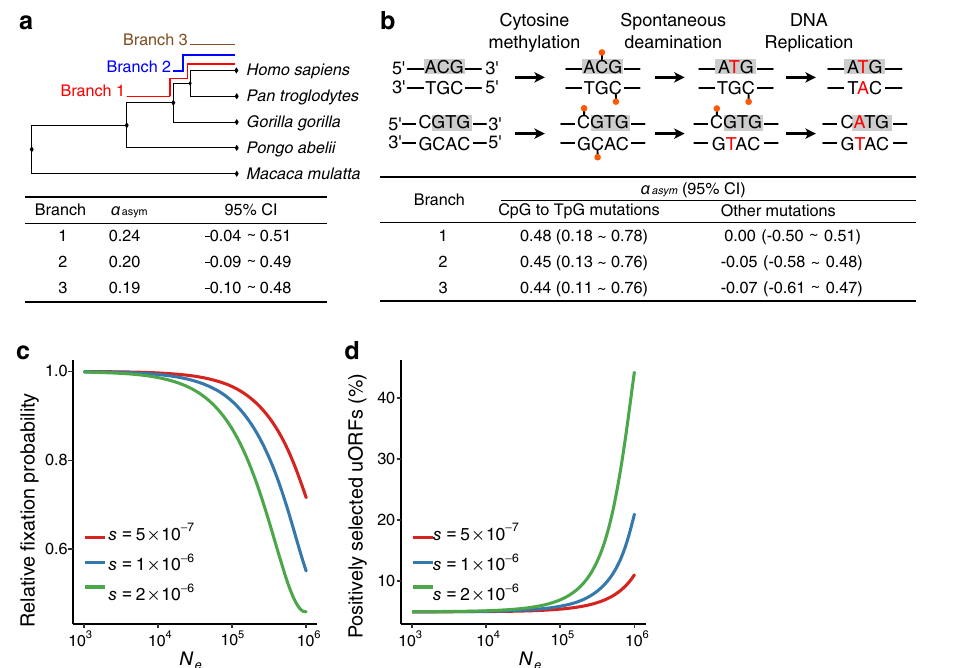
Fig. 2 Selection and effective population size ( N e ) shape the upstream open reading frame (uORF) prevalence in eukaryotes. a Asymptotic McDonald – Kreitman (AsymptoticMK) test of newly fi xed uORFs in the lineages leading to extant humans (branches 1, 2, and 3). The left panel shows the phylogeny of the fi ve primates related to the analysis. Rhesus macaque ( Macaca mulatta ) was used as the outgroup. The fraction of newly fi xed uORFs driven by positive selection ( α asym ) is shown in the bottom panel. b The result of AsymptoticMK tests for newly fi xed uORFs derived from CpG to TpG mutations and the other mutations on each branch. The two approaches by which CpG to TpG mutations create new ATGs in 5 ′ UTRs are illustrated above. Relative fi xation probability of newly originated uORFs ( c ) and the fraction of uORFs driven by positive selection ( d ) as a function of the N e of a simulated population. In the simulation, we assumed that bene fi cial and deleterious mutations presented the same absolute selective coef fi cient ( s ) and that there was no dominance ( h = 0.5). The fractions of newly originated uORFs that are deleterious, neutral, or bene fi cial are 75%, 20%, and 5%, respectively. Source data are provided as a Source Data fi